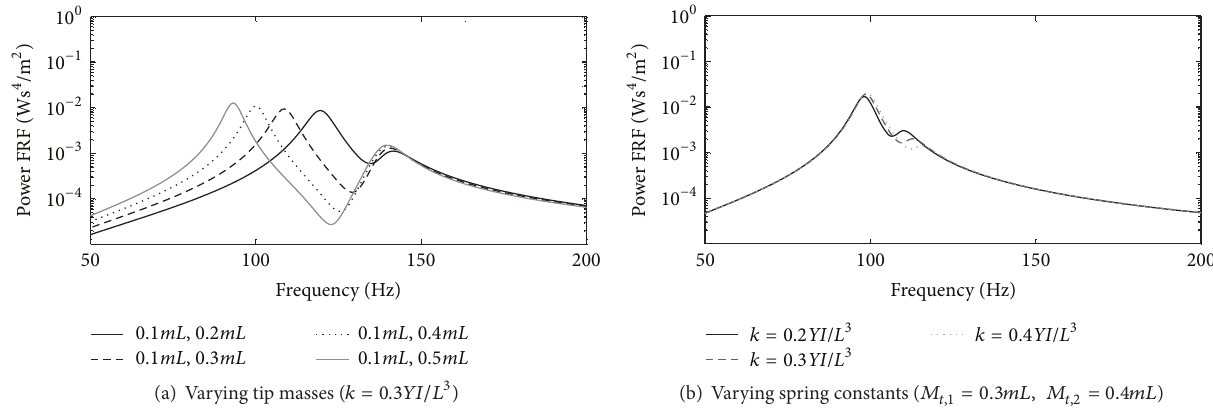
Figure 8: Power FRF of two bimorph beams with different combinations of tip masses and spring constants.